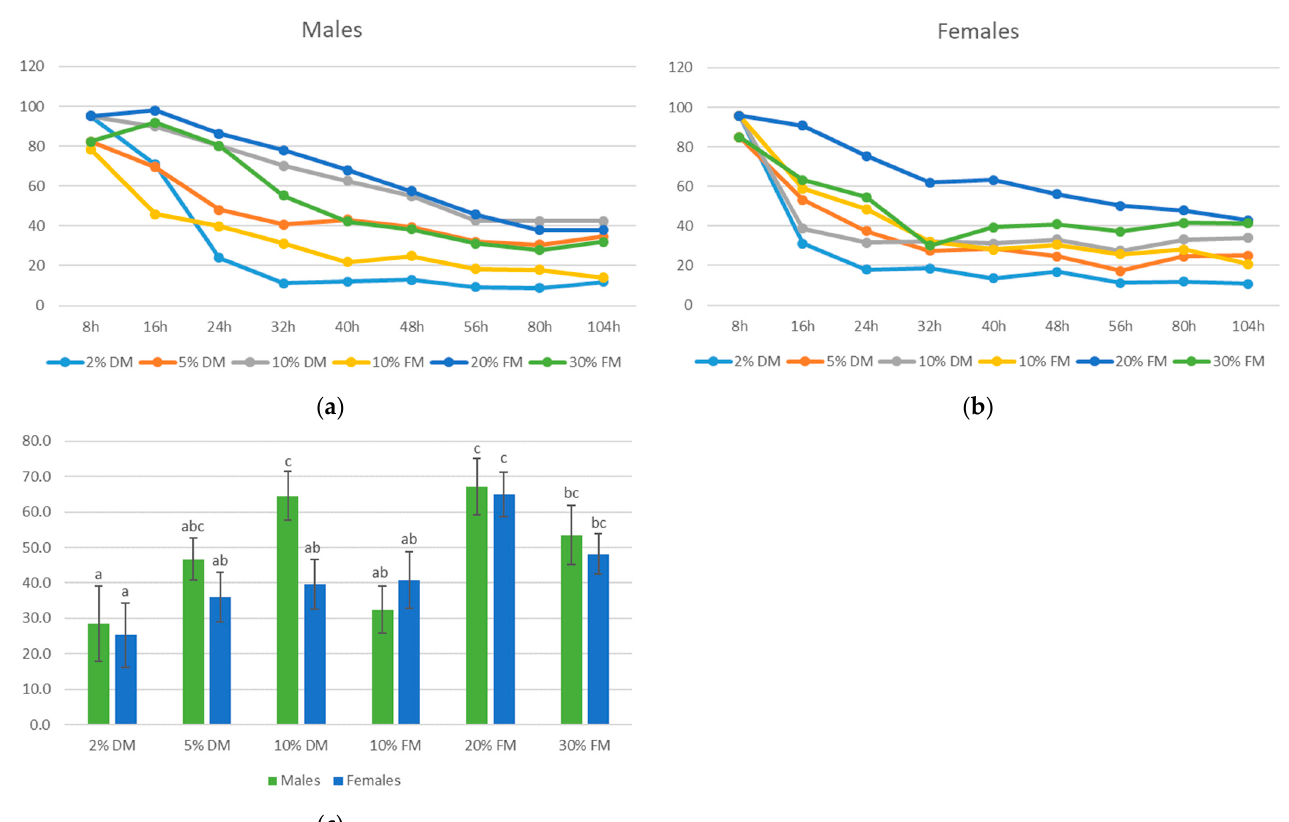
Figure 1. Absolute deterrence index (ADI) of fresh and dry matter extracts of tarragon at various concentrations for males ( a ) and females ( b ) of Sitona lineatus L. at respective hours of the experiment and the mean for all dates of observations ( c ). Means ± SE for individual sexes that are marked by different letters are statistically different ( α = 0.05). DM, dry matter; FM, fresh matter.